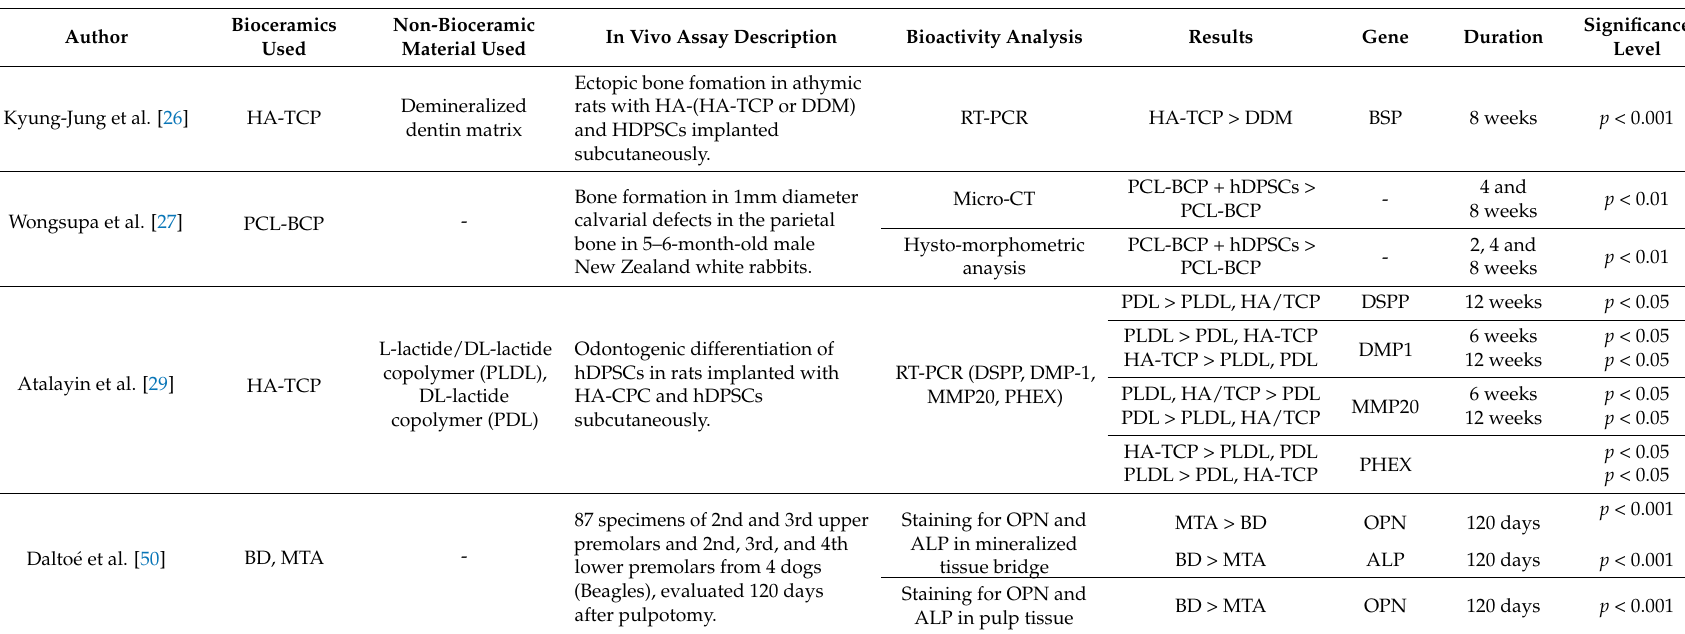
Table 18. Summary of the significant results of included studies categorized as animal